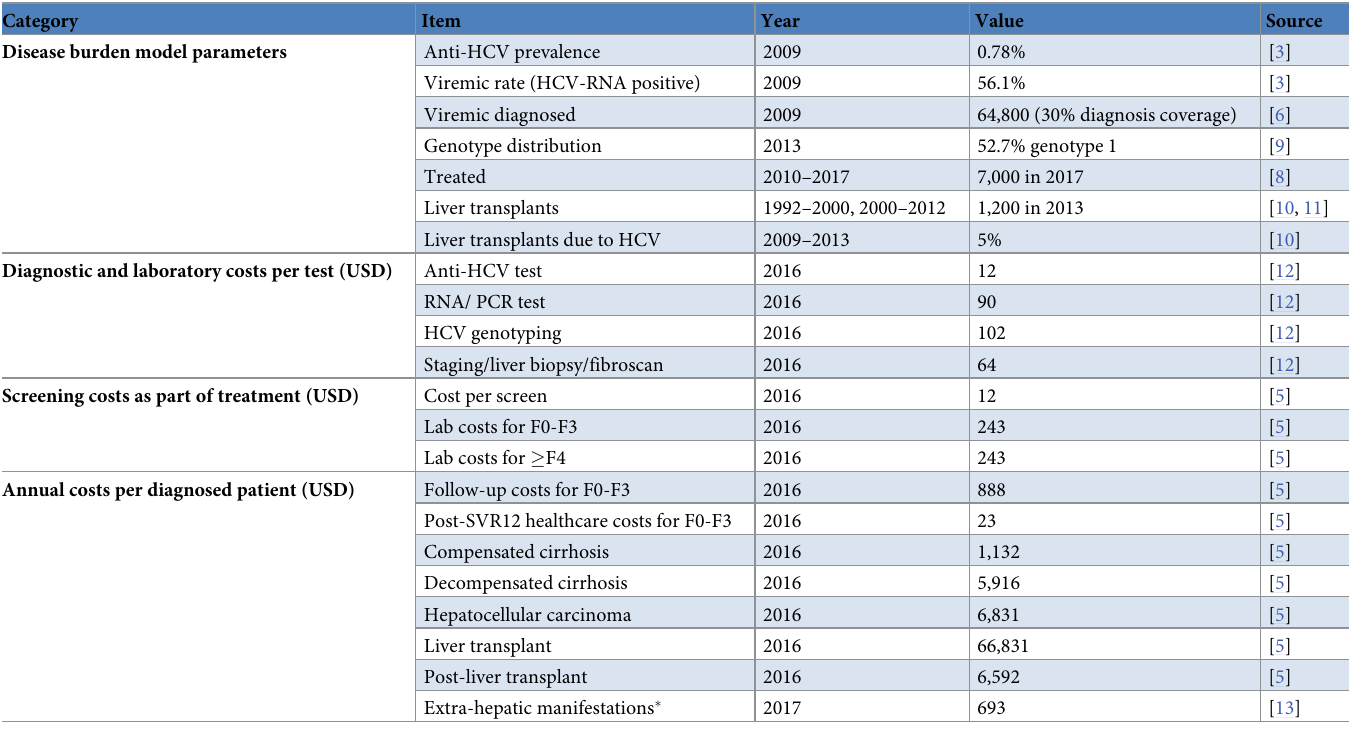
Table 1. HCV-related inputs for Korean impact of inaction disease burden